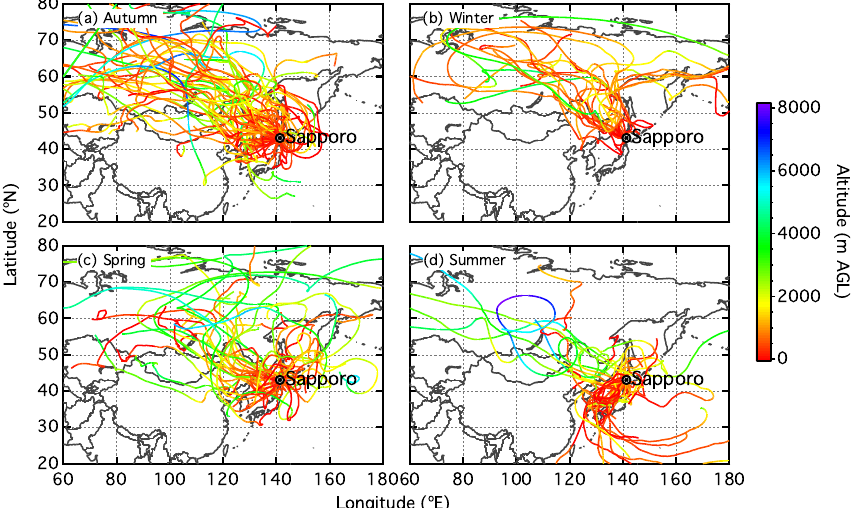
Figure 1. Plots of 10-day backward air mass trajectories arriving over Sapporo at 500ma.g.l.